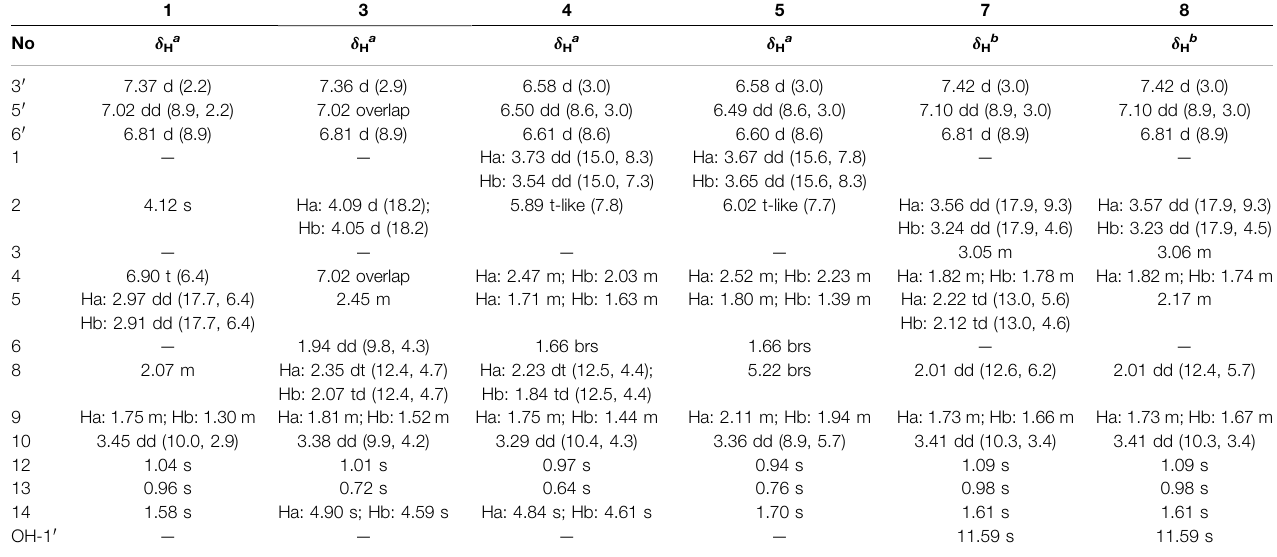
TABLE 1 | 1 H NMR (500 MHz) data of 1 , 3 – 5 , 7 , and 8 ( δ in ppm, J in Hz).